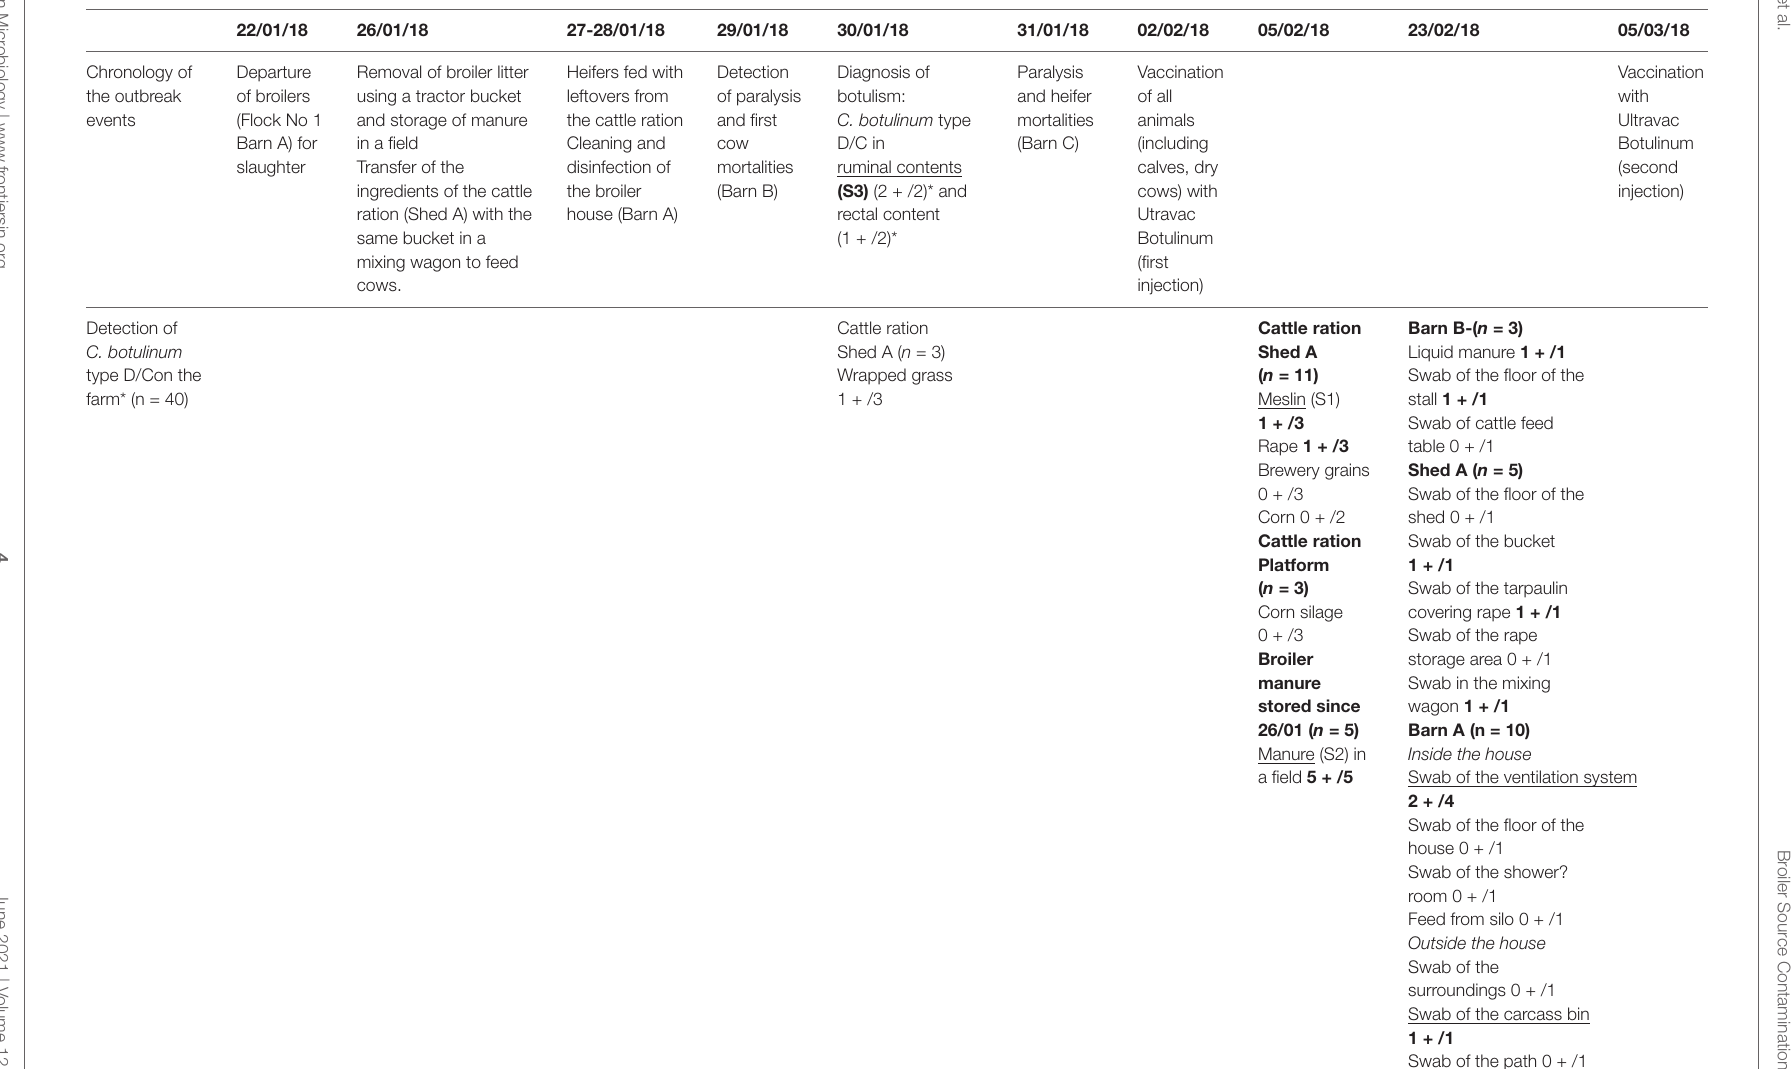
TABLE 1 | Chronology of the events on the farm affected by the cattle botulism outbreak type D/C and detection of C. botulinum type D/C during the